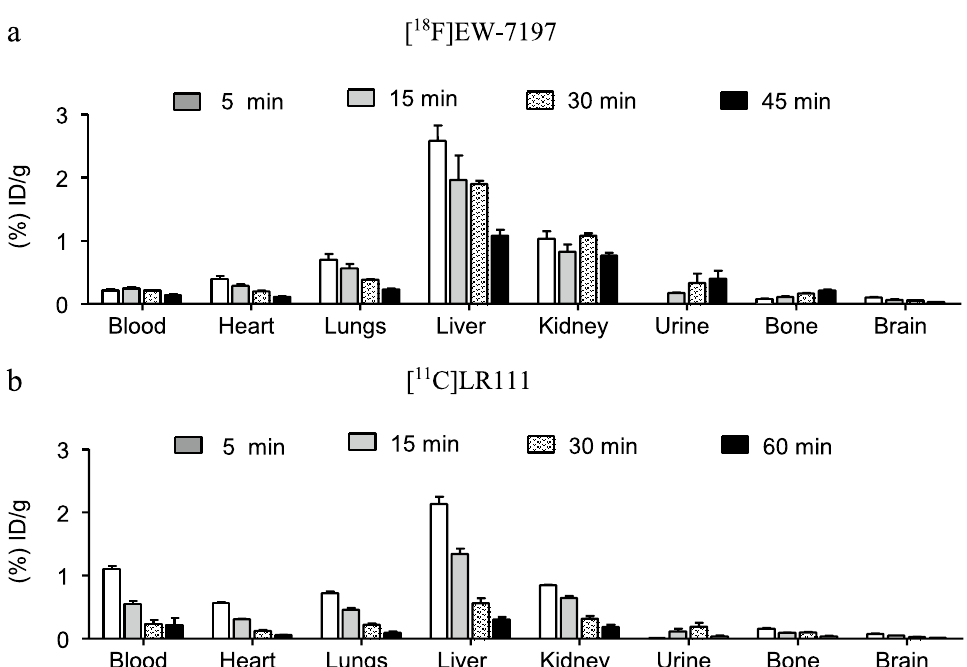
Fig. 5 a [ 18 F]EW-7197 and b [ 11 C]LR111 uptake derived from ex vivo biodistribution studies. Tracers were administered to healthy male Wistar rats, which were sacrificed at 5, 15, 30, 45 or 60 min p.i. ( n 4 per time point). Results are expressed as injected dose per gram tissue. Error bars represent = the standard error of the mean